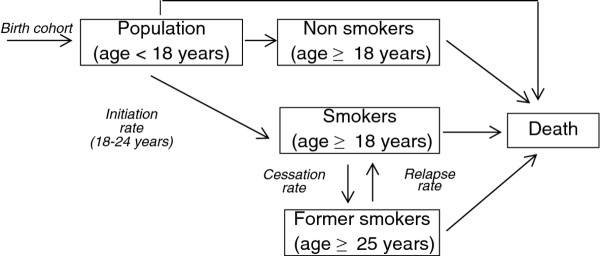
Model. Scheme of the model used to compute the prevalence of smoking.